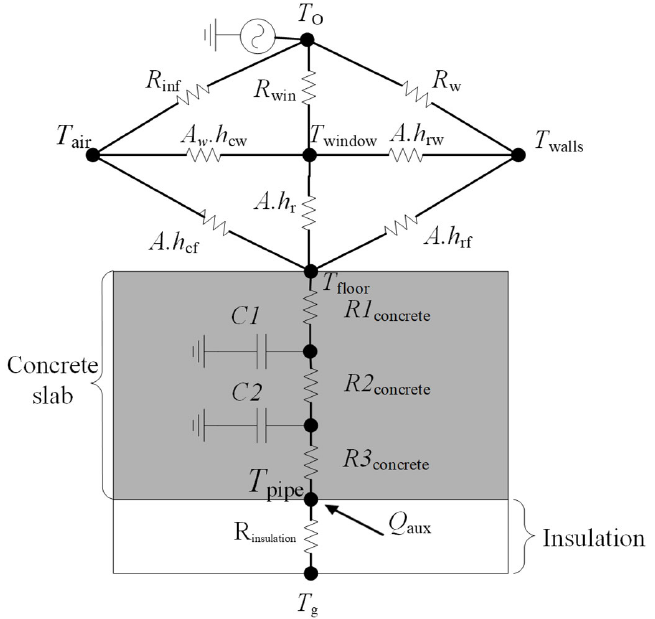
Figure 4. Thermal network model of the zone.